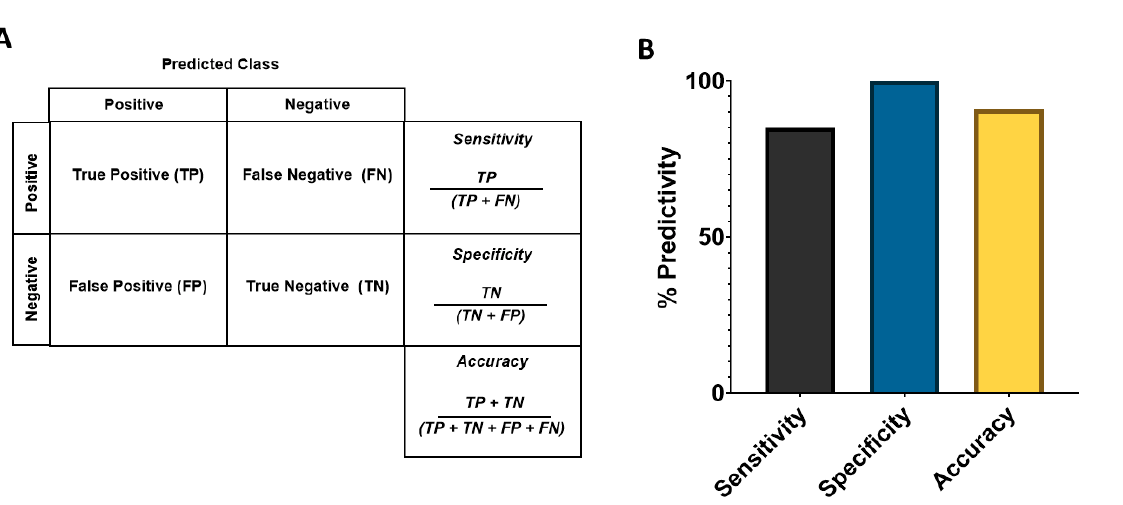
Figure 4. ( A ) Predicted class formulas. ( B ) Confusion matrix showing predictive values for hazard classification of drugs tested in the hiPSC-derived neurons co-cultured human primary astrocytes with FDSS assay. Sensitivity, specificity, and accuracy were derived from the true positive, false negative, false positive, and true negative classification of the 25 reference compounds in 2D hiPSC- derived neurons cultured with human primary astrocytes.